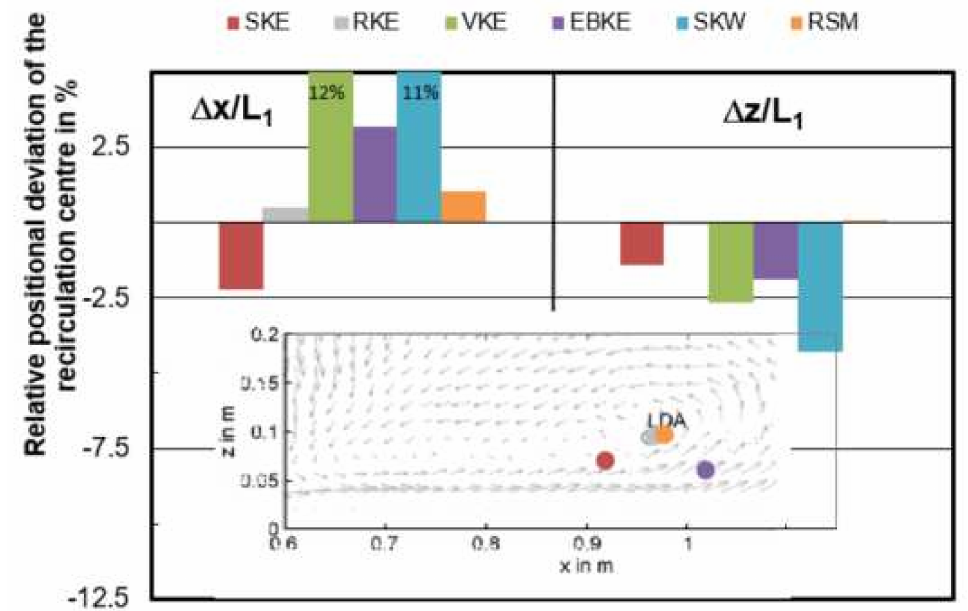
Figure 11. Relative positional deviation ∆ x/L 1 and ∆ z/L 1 of the recirculation center from CFD models with varied turbulence model (y/L 1 =